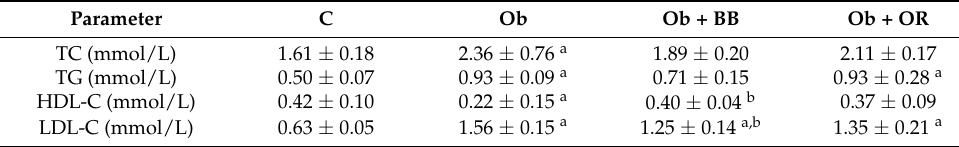
Table 5. Lipid profile parameters in all